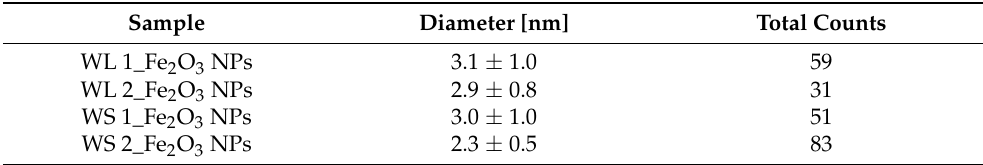
Table 2. Characteristics of the aqueous suspensions.